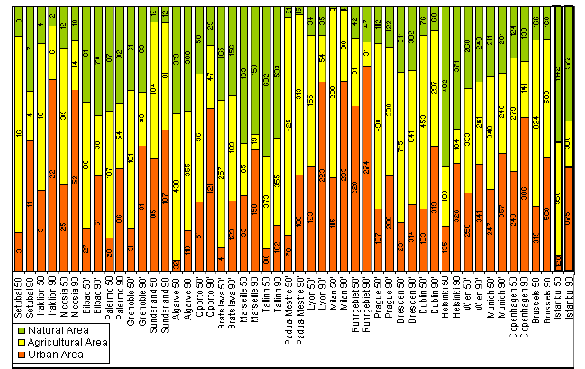
Figure 14: land-use transformation in “MOLAND”-cities